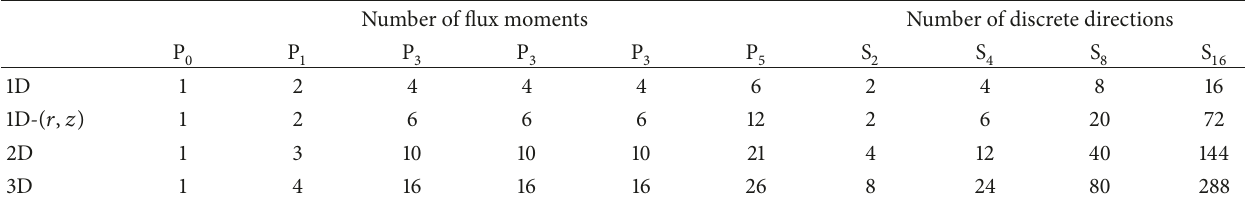
Table 1: Number of flux moment terms used in PARTISN for different Legendre expansion order 𝐿 and the number of discrete directions for different S 𝑁 fully symmetrical direction sets.